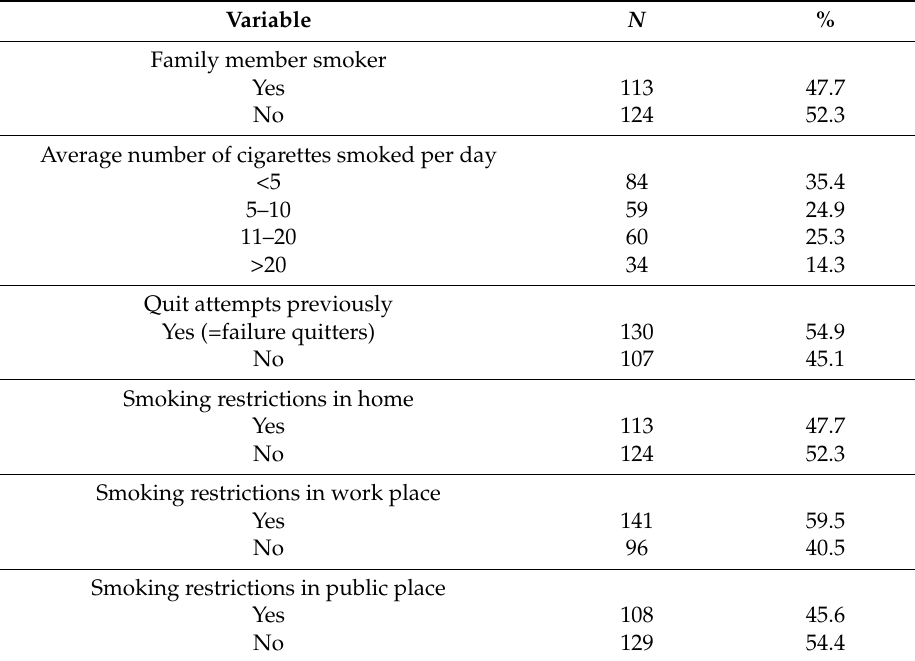
Table 2. Smoking conditions among current smokers.